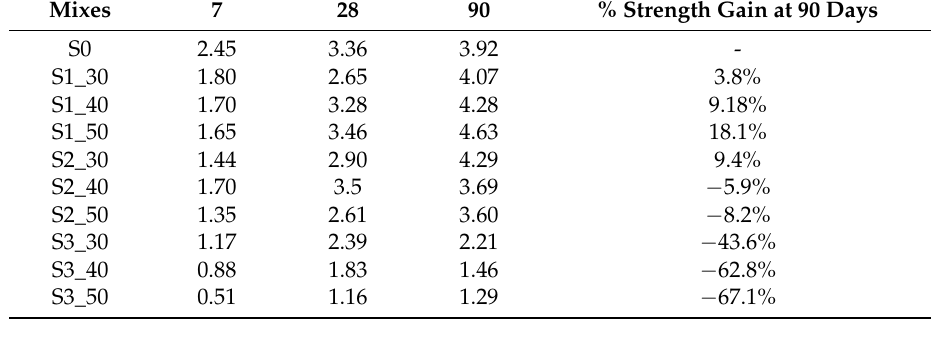
Table 3. Flexural strength results.